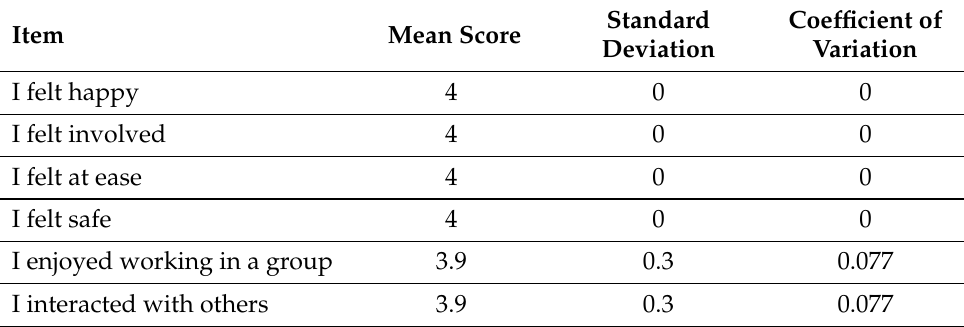
Table 3. Mean scores, standard deviations and coefficients of variation of the items of the simplified well-being